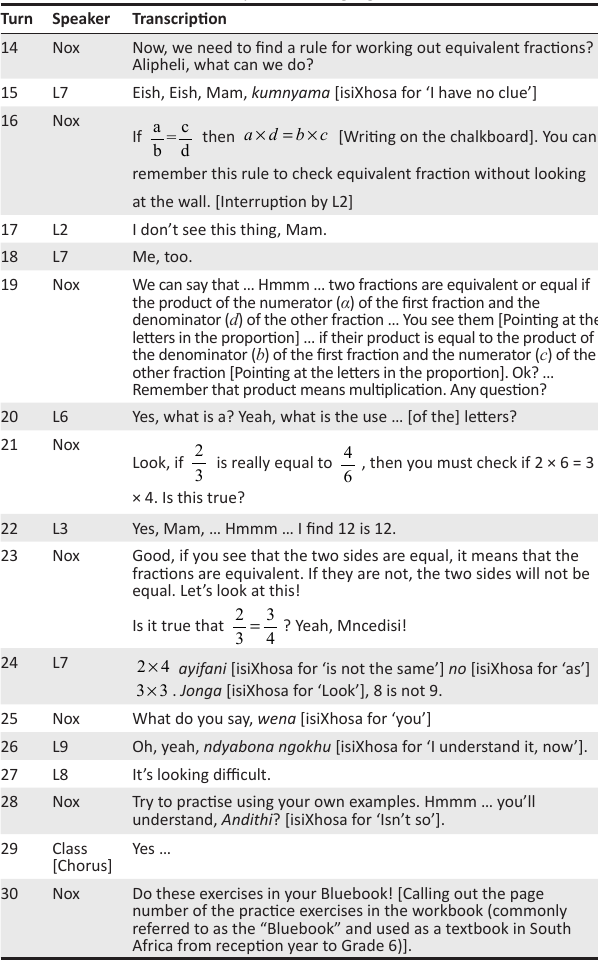
TABLE 3: Learners show difficulty with making a